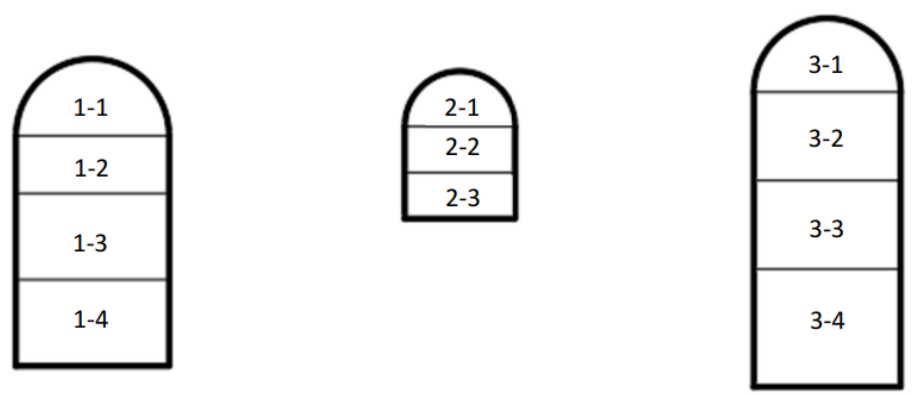
Figure 4. Excavation sequence of the three caverns.